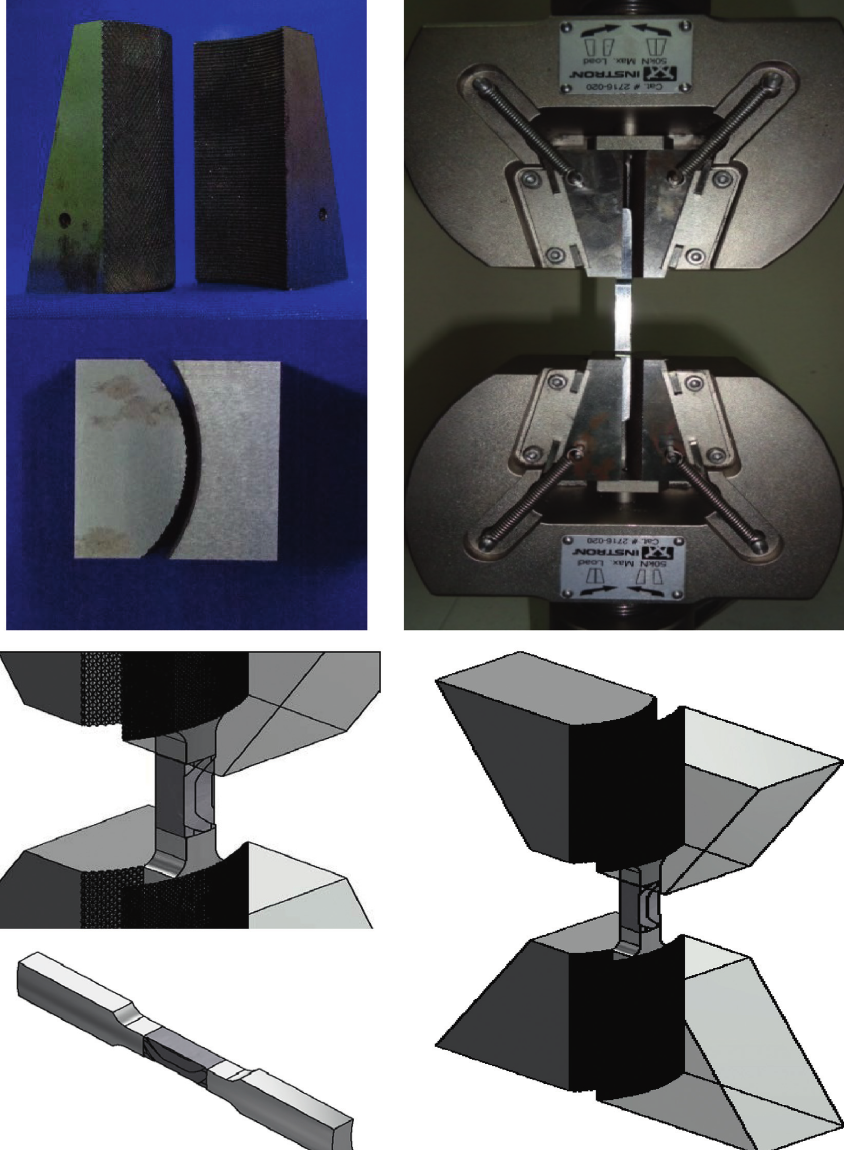
Figure 10: Universal testing machine and friction stir-welded AA 7075 aluminium alloy.